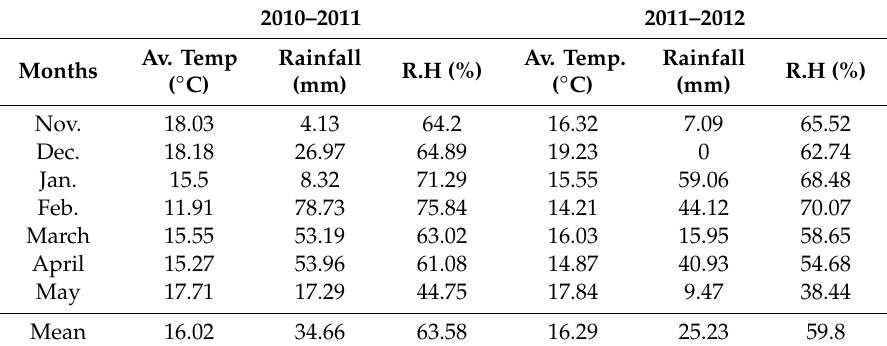
Table 1. Meteorological data during the growing seasons of wheat crop (2010–2012).